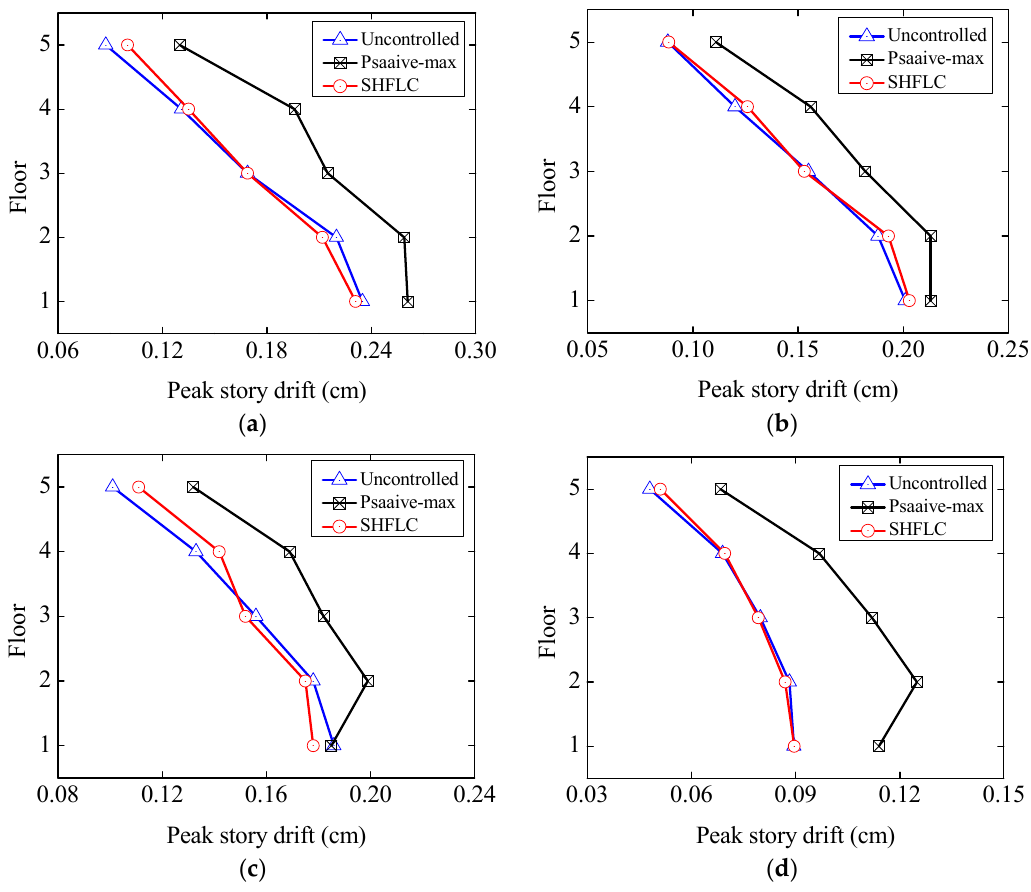
Figure 12. Average inter ‐ story drifts with four types of earthquakes: ( a ) near ‐ fault earthquakes with fling effect; ( b ) near ‐ fault earthquakes with rupture forward directivity; ( c ) near ‐ fault earthquakes without pulse ‐ effect; and ( d ) far ‐ field earthquakes.